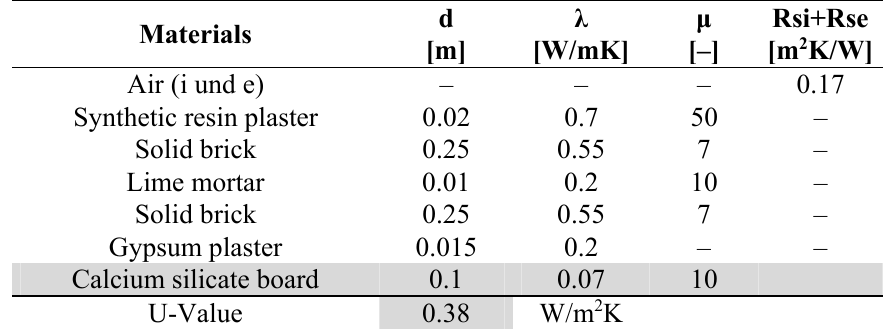
Table 4. Internal insulation with calcium silicate board. External wall renovation with 10 cm calcium silicate board, interior